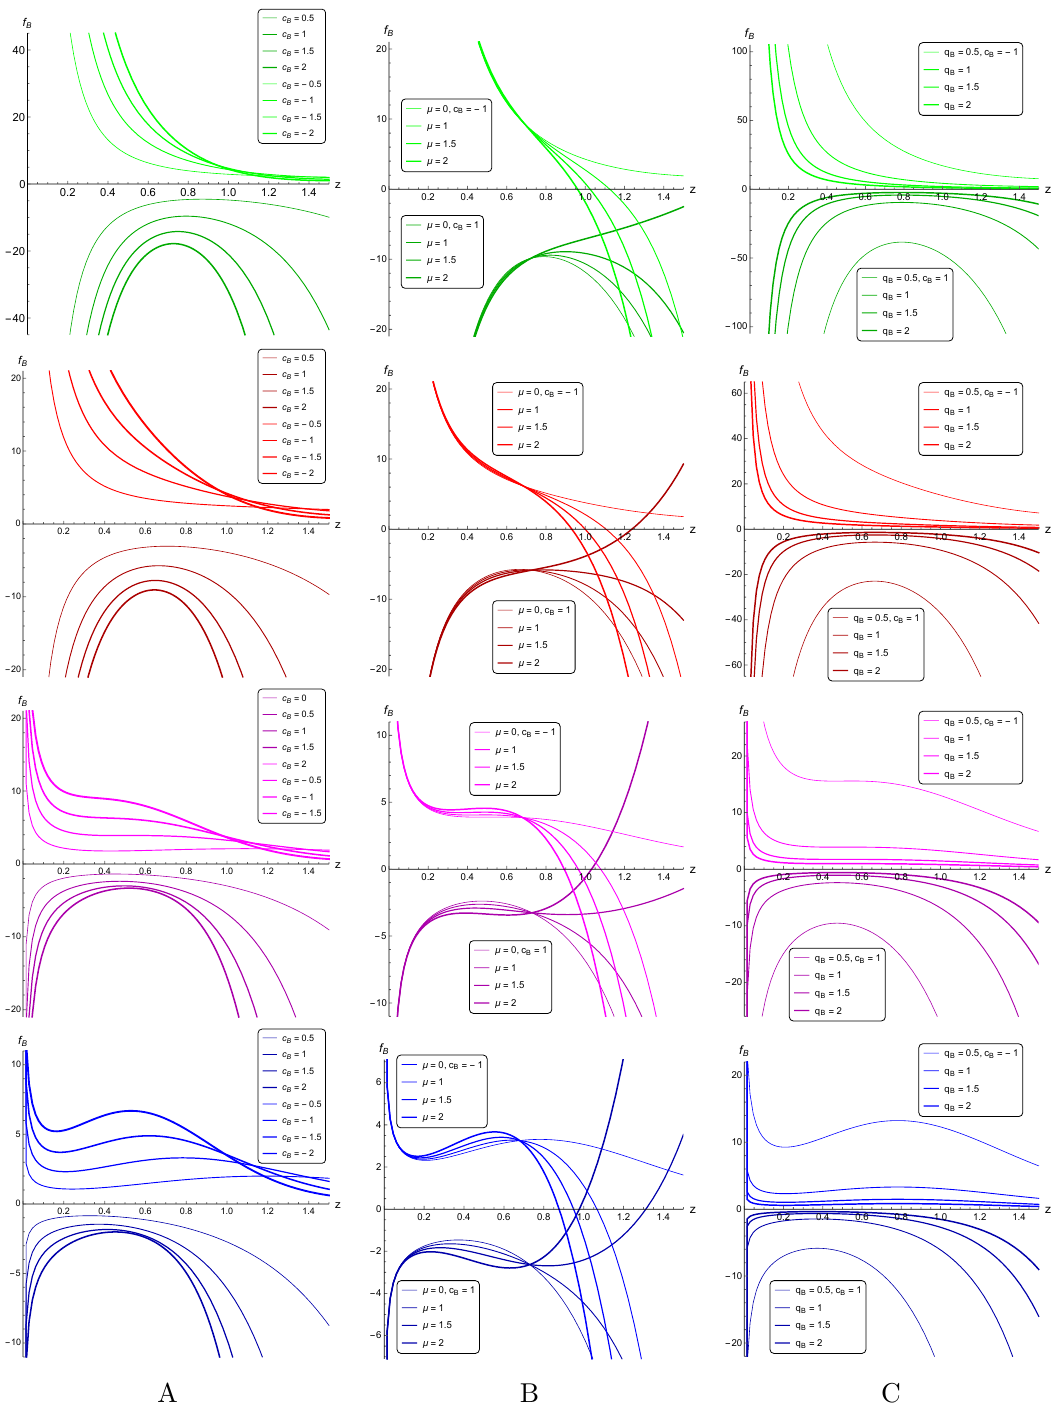
Figure 2 . Coupling function f B ( z ) for different c B , µ = 0 , q B = 1 (A), for different µ , c B = ± 1 , q B = 1 (B) and for different q B , µ = 0 , c B = ± 1 (C); ν = 1 (1-st line), ν = 1 . 5 (2-nd line), ν = 3 (3-rd line) and ν = 4 . 5 (4-th line), c = 0 . 227 , z h = 1